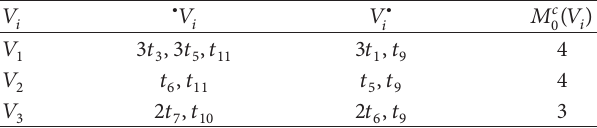
Table 3: Monitors 𝑉 𝑖 added for the net shown in Figure 2.